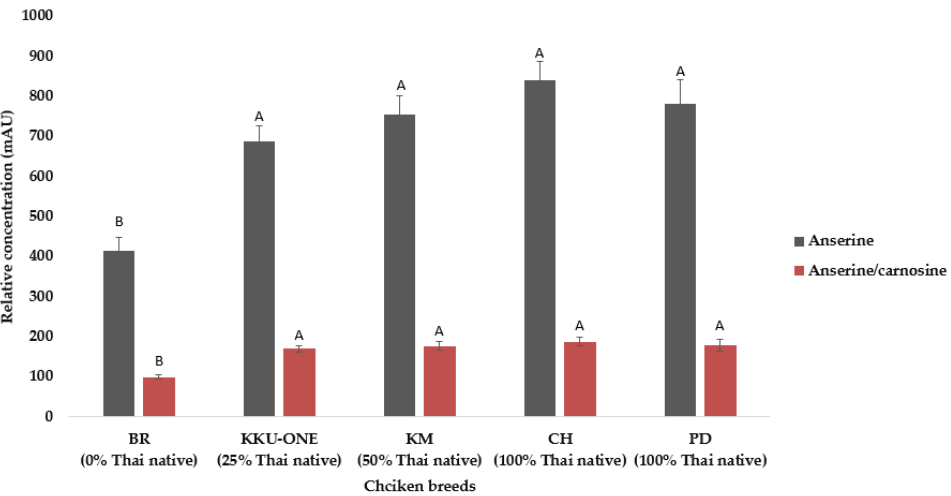
Figure 5. Relative concentrations of anserine (3.791 ppm) and anserine/carnosine (3.22 ppm) in chicken breast extracts by 400-MHz 1 H-NMR spectra (0–10 ppm) from PD = Pradu Hang Dam Mor Kor 55 (100% Thai native), CH = Chee KKU 12 (100% Thai native), KM = Khai Mook E-san (50% Thai native), and KKU-ONE (25% Thai native). A,B represent the level of significance of the differences among the genotypes ( p < 0.01). Table 2. Relative concentrations of anserine and anserine/carnosine in chicken breast extracts.